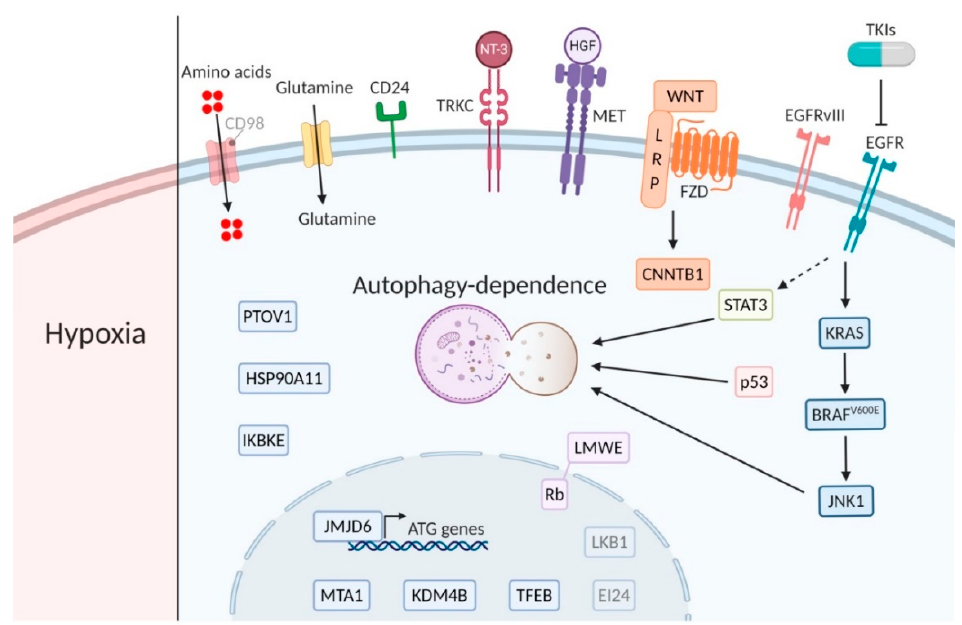
Figure 2. Major players of the main signaling pathways. Bright biomarkers indicate amplification or active signaling and blurred biomarkers indicate low activity or expression in relation to autophagy dependence (created using Https://Biorender.com).